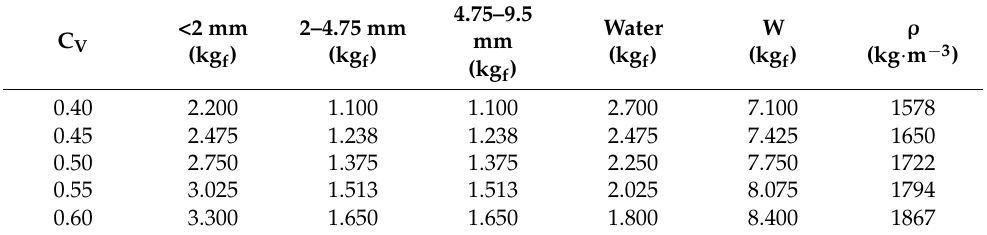
Table 5. Weight of debris flow samples according to volumetric concentration of sediment C V .